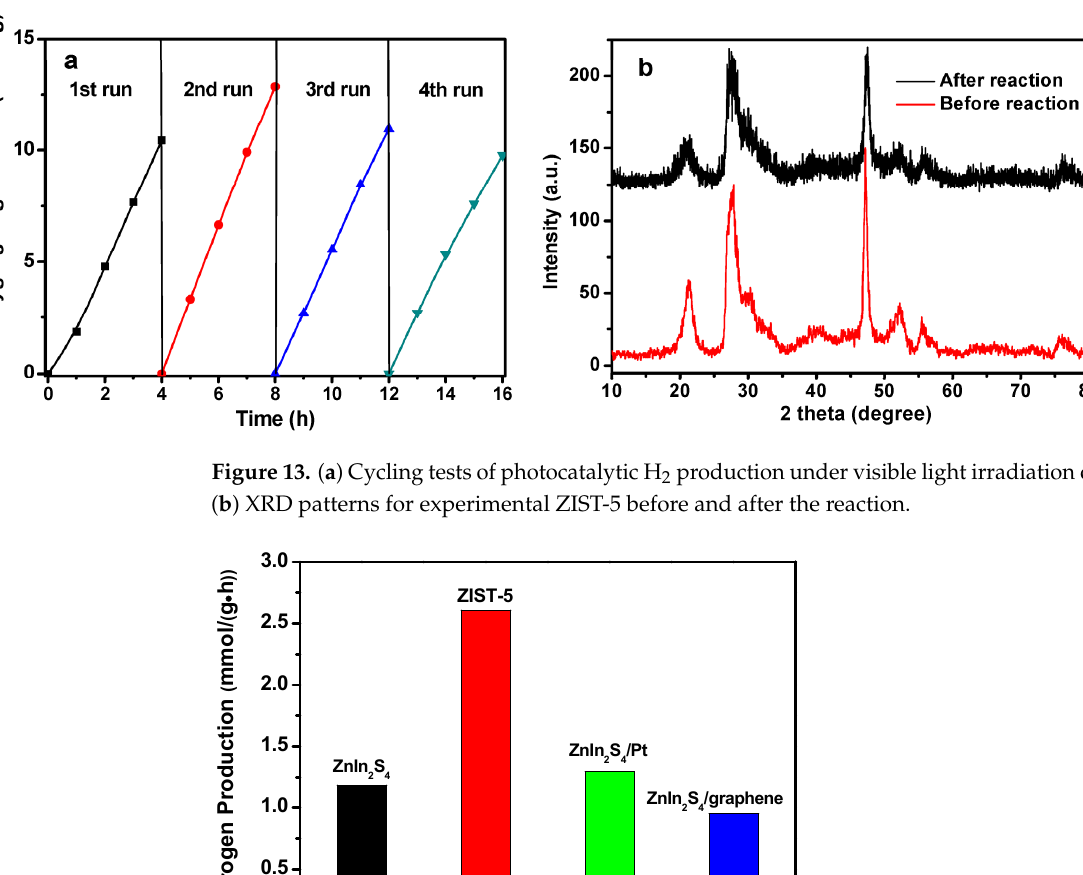
Figure 12. ( a ) Photocatalytic H 2 evolution over ZnIn 2 S 4 and ZnIn 2 S 4 /Ti 3 C 2 composites with different Ti 3 C 2 content under visible light irradiation. ( b ) Rate of H 2 evolution of ZnIn 2 S 4 /Ti 3 C 2 composites with different Ti 3 C 2 content under visible light irradiation.